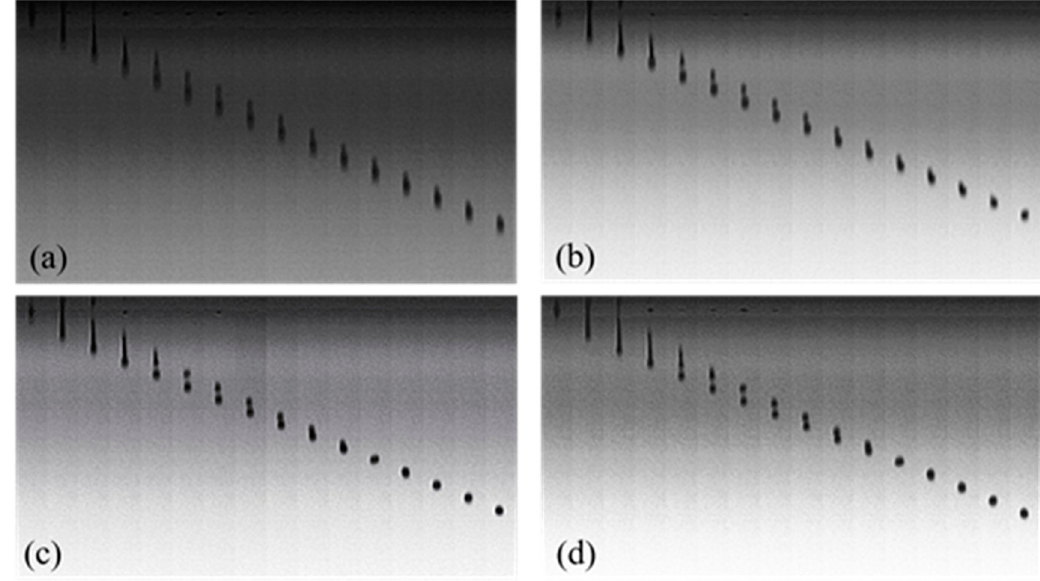
Figure 9. Droplet formation of 7% Red 218 dye solutions containing 30% PEG400 at different jetting frequency and 25 °C: ( a ) 1500 Hz; ( b ) 5000 Hz; ( c ) 10,000 Hz; ( d ) 20,000 Hz.